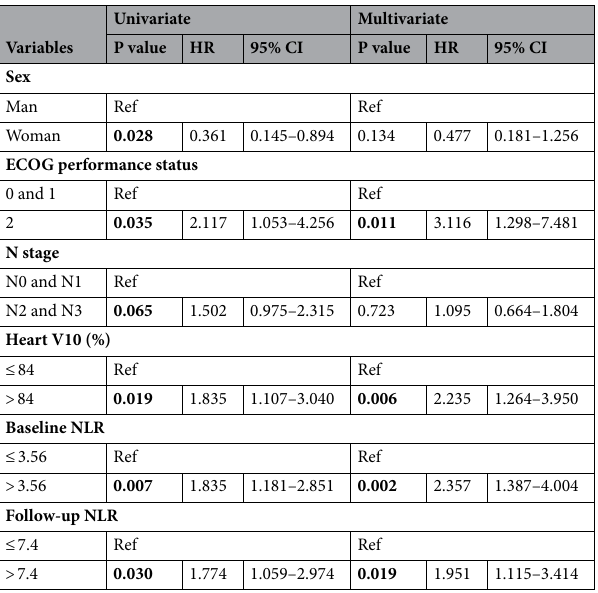
Table 3. Univariate and multivariate Cox regression of clinical, hematologic, and dosimetric variables associated with overall survival.